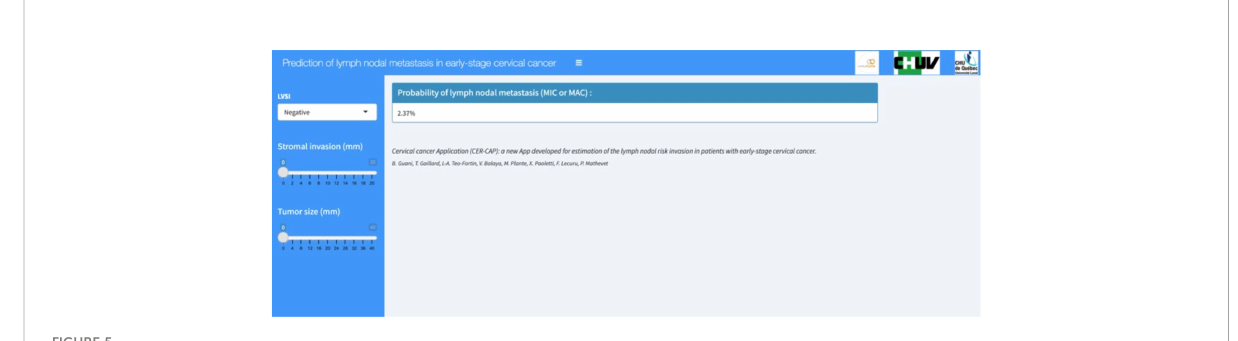
FIGURE 5 CER-CAP webpage screenshot. LVSI, lymph vascular space invasion; MIC, micrometastasis; MAC, macrometastasis